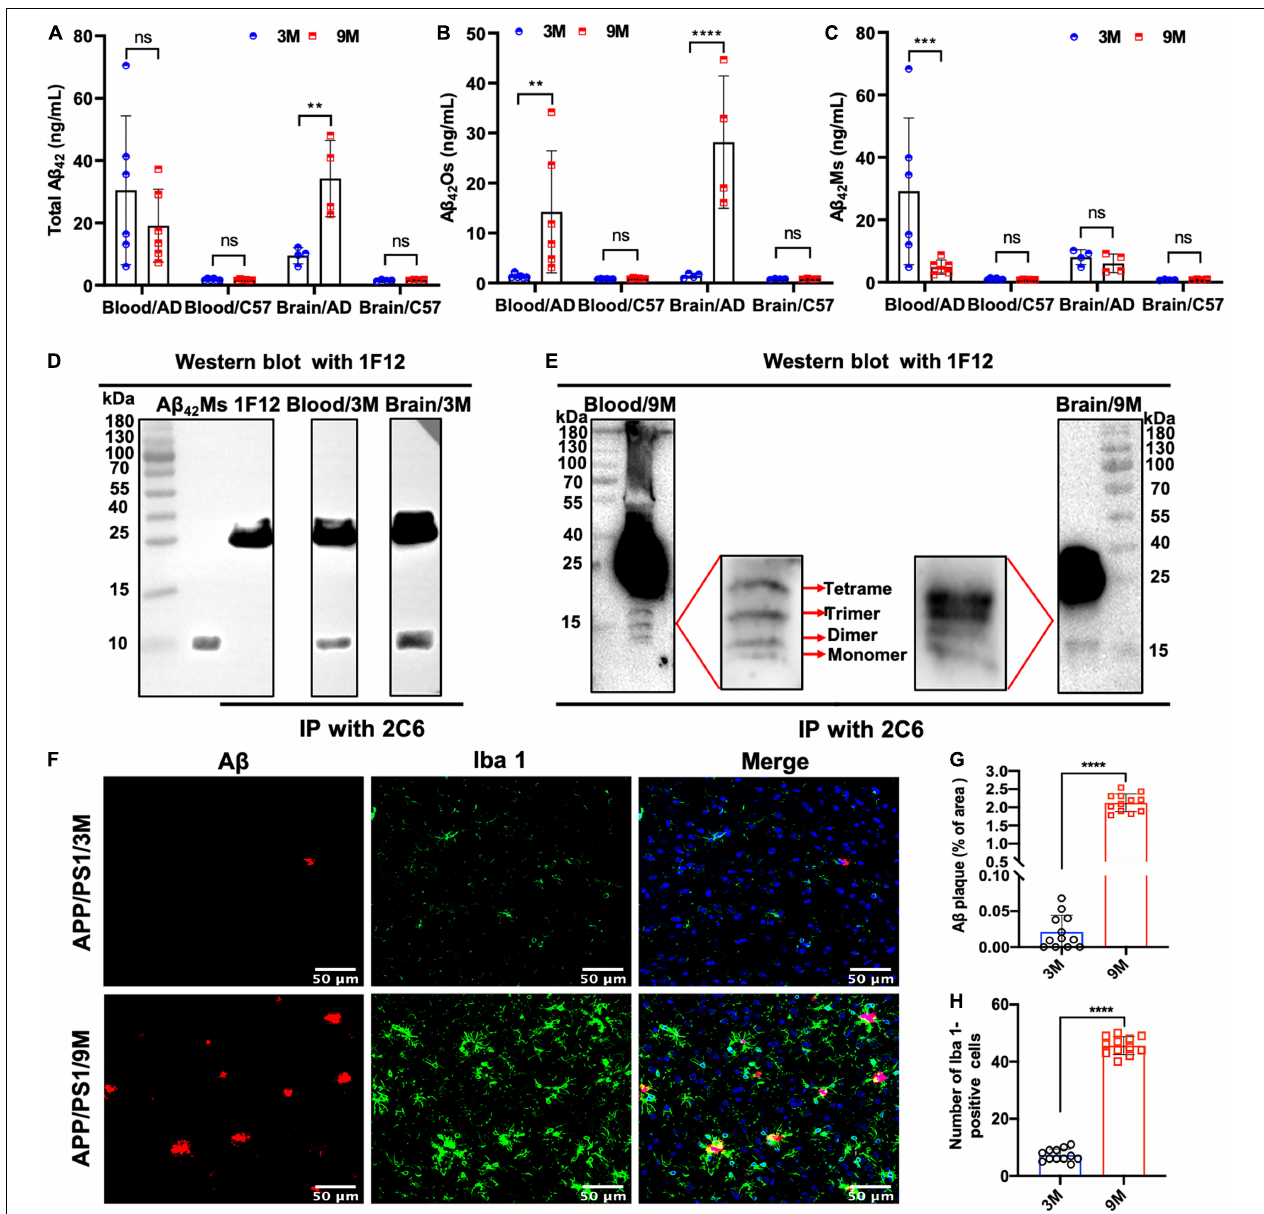
FIGURE 3 | Dynamic detection of the changes of A β 42 Ms and A β 42 Os in blood and brain of APP/PS1 mice by 1F12/2C6 and 1F12/1F12 ELISA. The level of total A β 42 (A) , A β 42 Os (B) , and A β 42 Ms (C) in the blood ( n = 6) and brain ( n = 4) of 3- and 9-month-old APP/PS1 and C57BL/6J mice. Total A β 42 in the blood and brain of 3 (D) or 9-month-old (E) APP/PS1 mice were enriched with immunoprecipitation (2C6) and visualized via Western blotting (1F12). (F) Confocal fluorescence images of A β plaque and Iba 1-positive cells staining in 3 or 9-month-old APP/PS1 mice. A β plaque (G) and Iba 1-positive (H) areas in the brains of 3- or 9-month-old APP/PS1 mice. Data are presented as means ± SEM. Two-way analysis of variance (ANOVA) was used in (A–C) for multigroup comparisons. Unpaired t-test was used in (G,H) for two-group comparisons. Statistical significance is indicated in the figures by ** p < 0.01, *** p < 0.001, **** p < 0.0001, and n.s. (indicating no